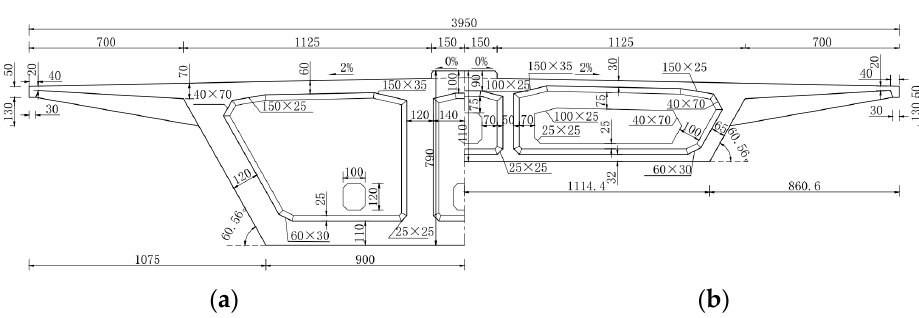
Figure 1. Bridge layout diagram (unit: cm).